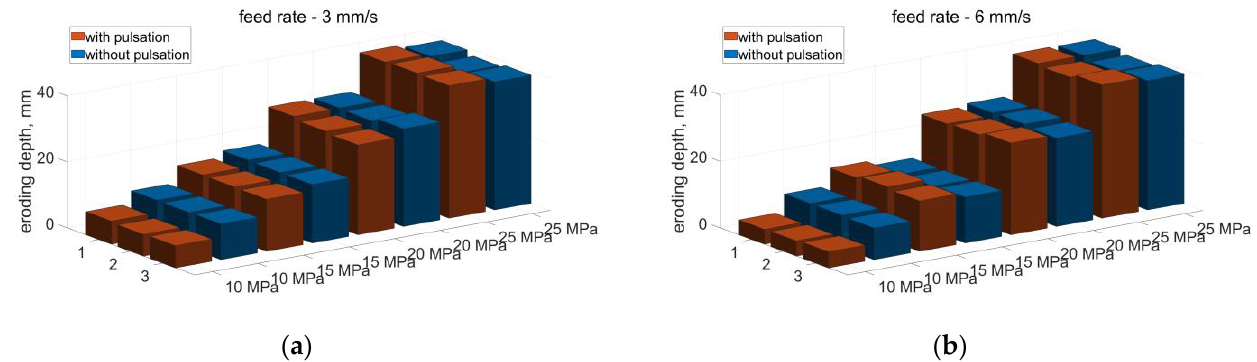
Figure 24. Comparison of the eroding depth of aerated concrete with a water jet (pulsating and without pulsation) produced in the drilling head with a feed rate of: ( a ) 3 mm/s, ( b ) 6 mm/s.